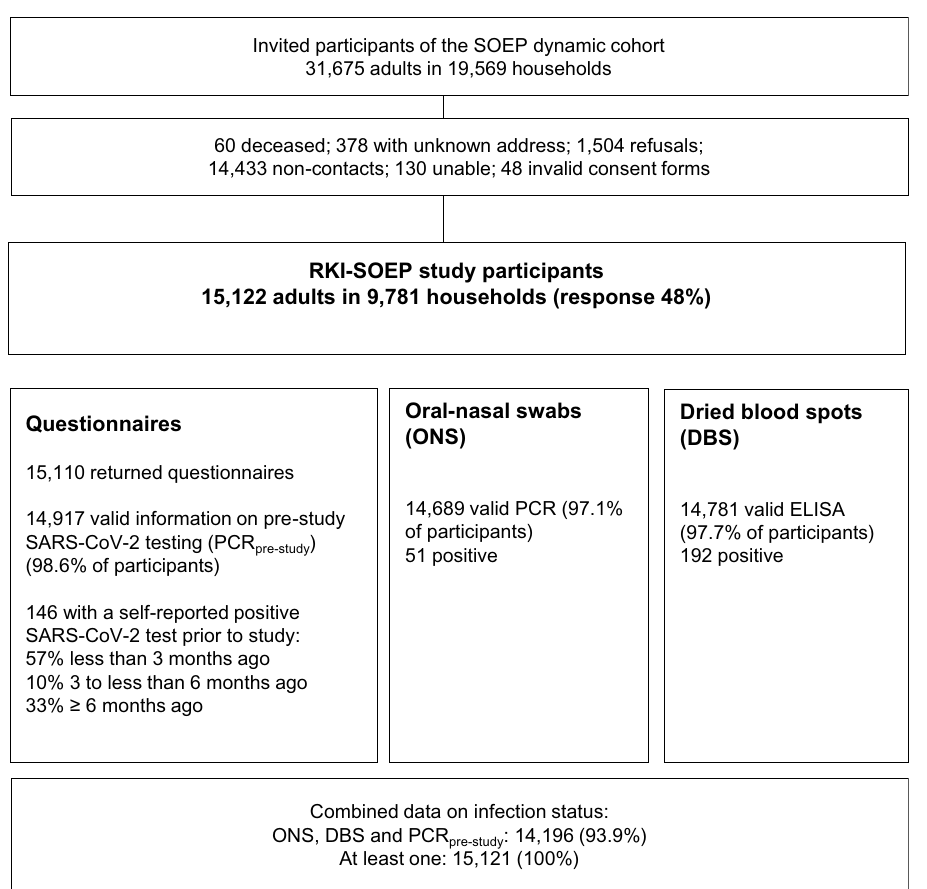
Figure 2. Flow-chart of study design of the RKI-SOEP study. Percentages are